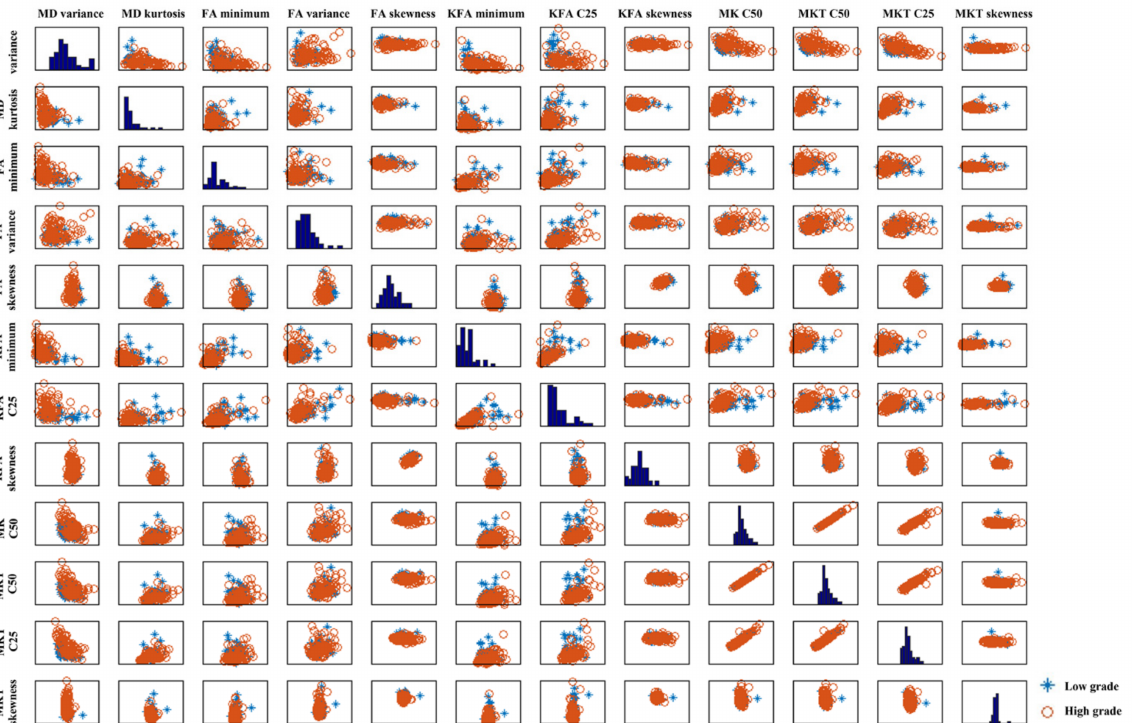
Figure 4. Scatter plots of the derived high-level features showing their pairwise correlations with respect to glioma grade. The figure is composed of scatter plots for each pairwise combination of the features (MD variance, MD kurtosis, FA minimum, FA variance, FA skewness, KFA minimum, KFA C25, KFA skewness, MK C50, MKT C50, MKT C25, MKT skewness). The sub axis of each of these scatter plots represent the range of the respective feature (either in x or y direction); the diagonal shows the histogram of the distribution of each feature in the data. Blue stars represent low-grade samples, whereas orange circles represent high-grade